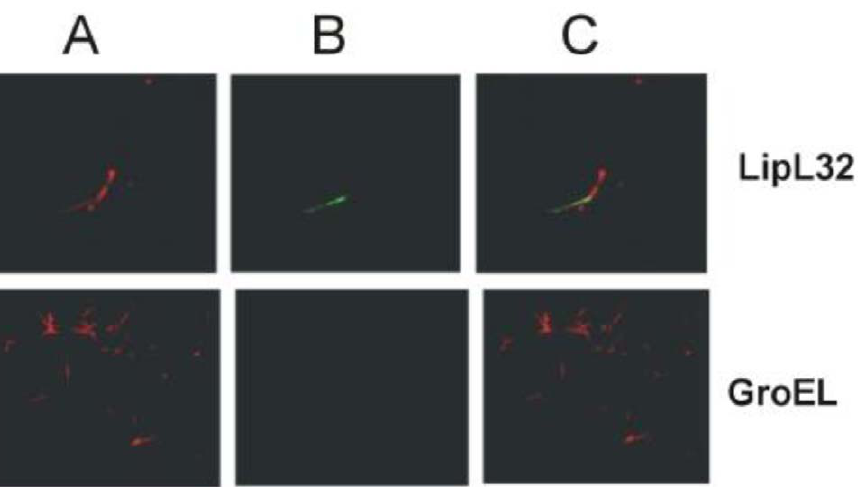
Figure 6. Reused from: PLoS One. 2011; 6(7): e21962. Confocal microscopy was performed with live L. interrogans using antisera specific for LIC10258, LIC12880, LIC12238, LipL32 (surface-exposed lipoprotein) and GroEL (protoplasmic cylinder marker). FITC-conjugated secondary antibodies were used to detect the surface-bound antibodies (B). Leptospires were identified by propidium iodide (A) staining of the DNA. Co-localization is shown in the merged images (C).